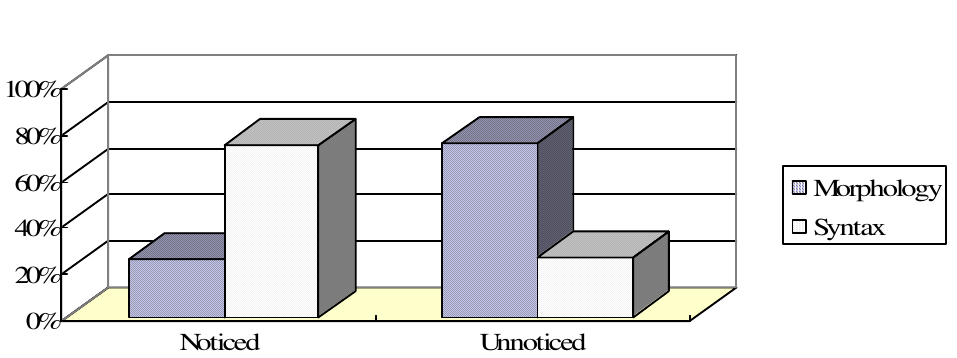
Learner’s Noticing of Complex